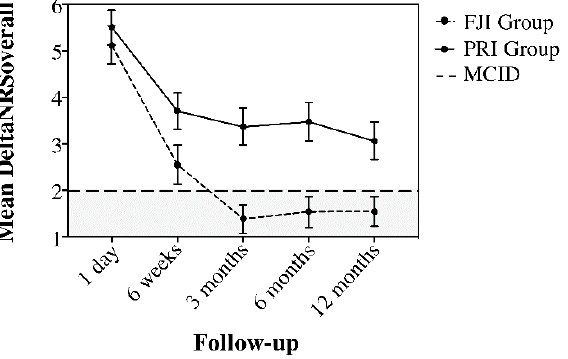
Figure 3. Comparison of deltaNRSoverall between the FJI and PRI groups over the follow-up period to illustrate the duration of the treatment effect concerning the minimal clinically important difference (MCID), (horizontal line at a DeltaNRS of 2). The FJI group fell below the horizontal line in the